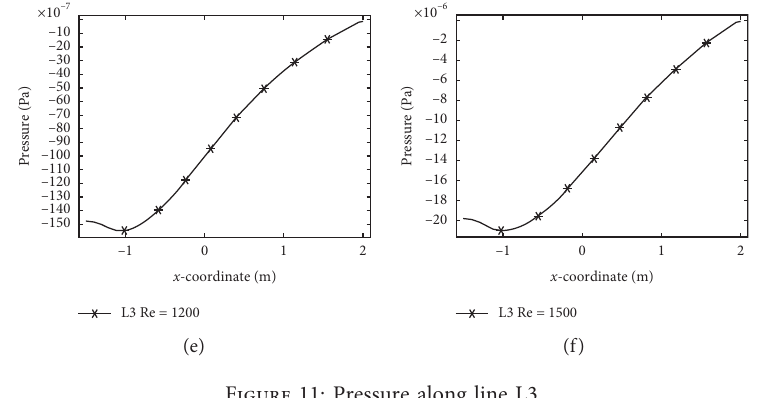
Figure 11: Pressure along line L3.